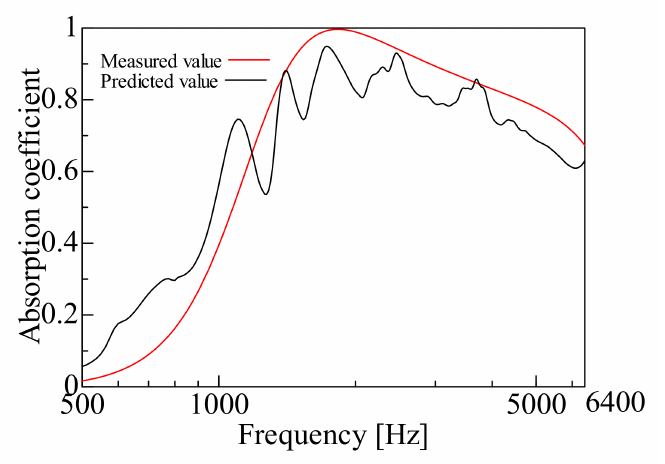
Figure 14. Comparison between the experiment and prediction (Sample F, m = 1.10 g/m 2 , t = 230 µ m, ρ = 353 kg/m 3